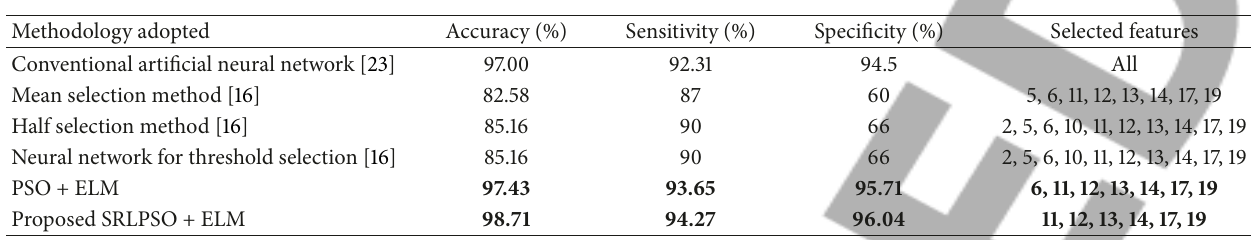
Table 6: Classification results with Hepatitis dataset.